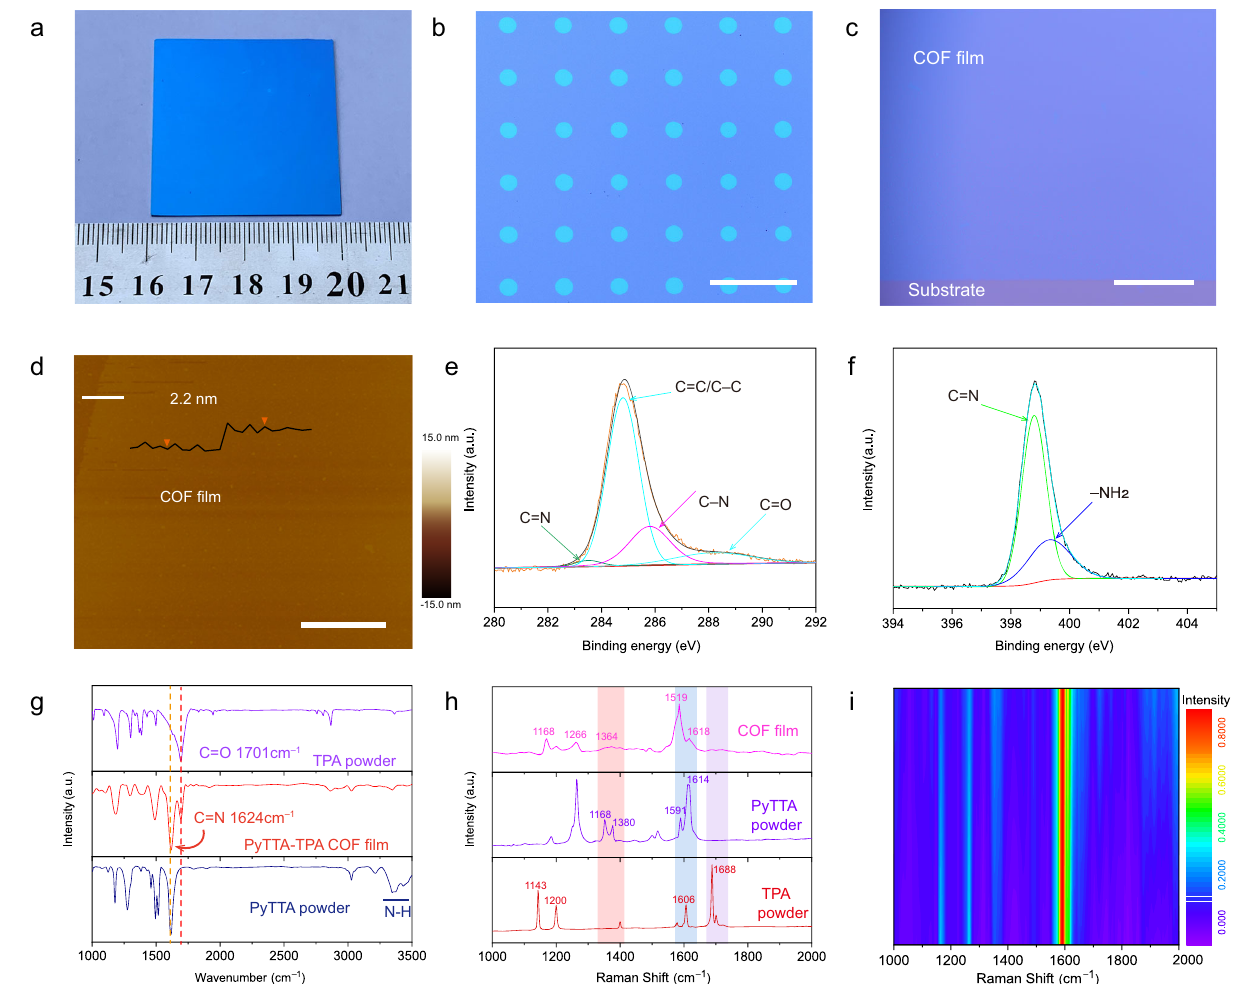
Fig. 2 Morphology and spectral characterizations of PyTTA-TPA COF fi lms. a Photograph of 2D PyTTA-TPA COF fi lm grown on a SiO 2 /Si substrate. b Optical image of PyTTA-TPA COF patterns. Scale bar 100 μ m. c High-magni fi cation optical image of the PyTTA-TPA COF fi lm. Scale bar 50 μ m. d AFM image of the 2D PyTTA-TPA COF fi lm with a thickness of ~2.2 nm. Scale bar 2 μ m. e , f C1s and N1s XPS spectra of 30-nm-thick PyTTA-TPA COF fi lm. g FT- IR spectra of 30-nm-thick PyTTA-TPA COF fi lm, PyTTA and TPA powder. h Raman spectra of 30-nm-thick PyTTA-TPA COF fi lm, PyTTA and TPA COF powder. i A contour map with multiple sets of normalized Raman data selected from Raman mapping